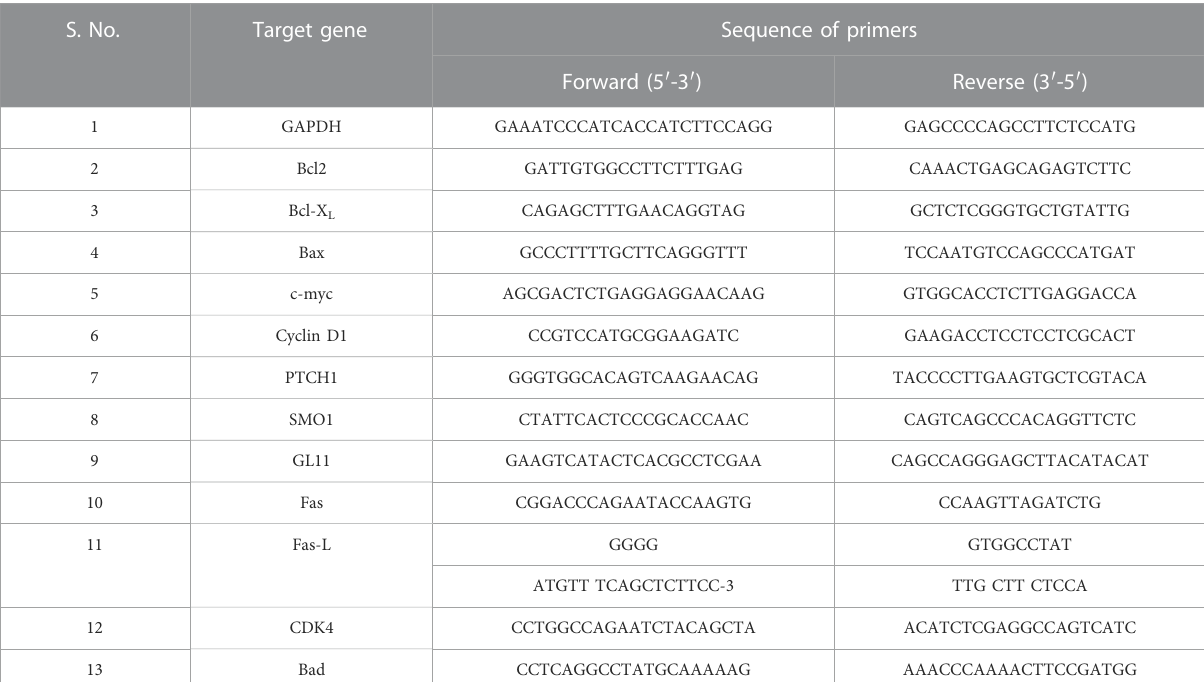
TABLE 1 List of primers used for